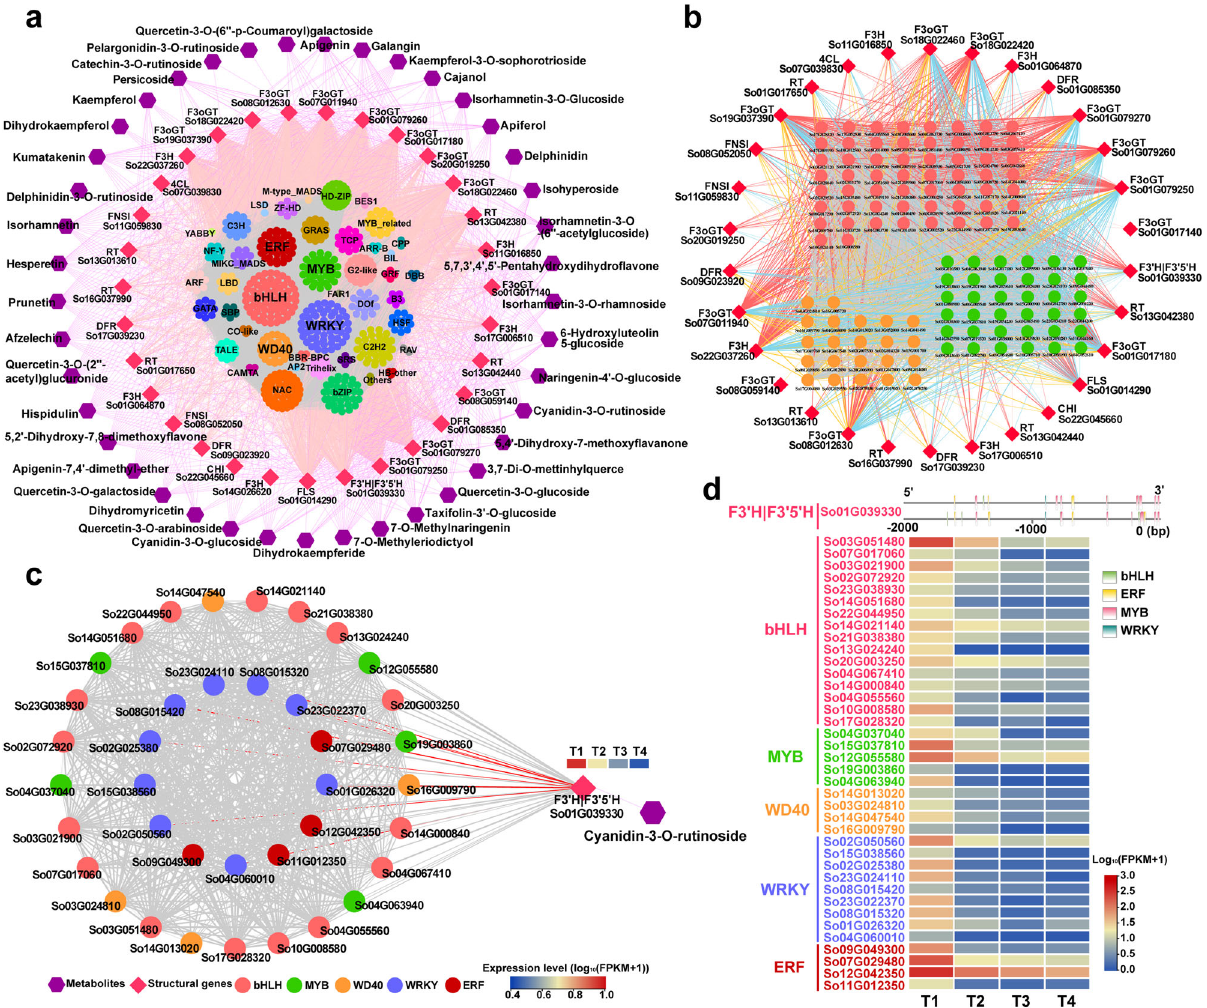
Fig. 5 Sub-network for fl avonoids metabolic pathways at the early stage of fl owering. a Sub-network for fl avonoids metabolism. The network consists of metabolites (purple), structural genes (pink) and TFs from the outside to the inside. b Sub-network for fl avonoids metabolism containing only the three families of TFs MYB (green), bHLH (pink), and WD40 (orange) at the early fl owering stage. The structural genes were linked to bHLH , MYB and WD40 in red, blue, and orange lines, respectively. c Resolved one of the metabolisms of Cy3Ru and regulation for F3'H|F3'5'H gene involved. And 38 TFs (sixteen bHLH , fi ve MYB , four WD40 , nine WRKY and four ERF ) identi fi ed as its direct regulators. d TFs (from Fig. 5c) heat-maps of gene expression pro fi les (log 10 (FPKM + 1)) at the four fl ower opening stages and DNA binding sites of F3'H|F3'5'H gene (from Fig. 5c) in 5'UTR upstream 2Kb. The bar color change from blue to red indicates the expression from low to high. The PCC value increases from small to large, the width of the edges changes from thinner to thicker in the